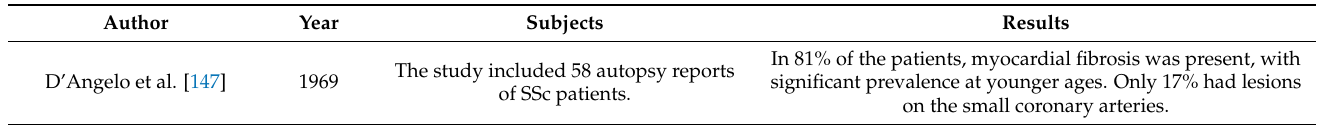
Table 6. Histopathological studies performed on SSc patients’